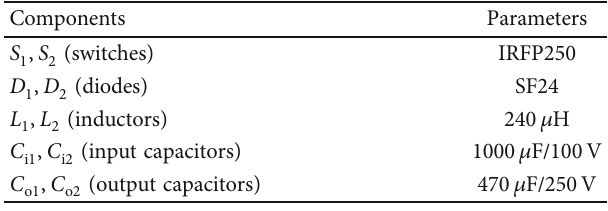
Figure 10: The waveforms of output.